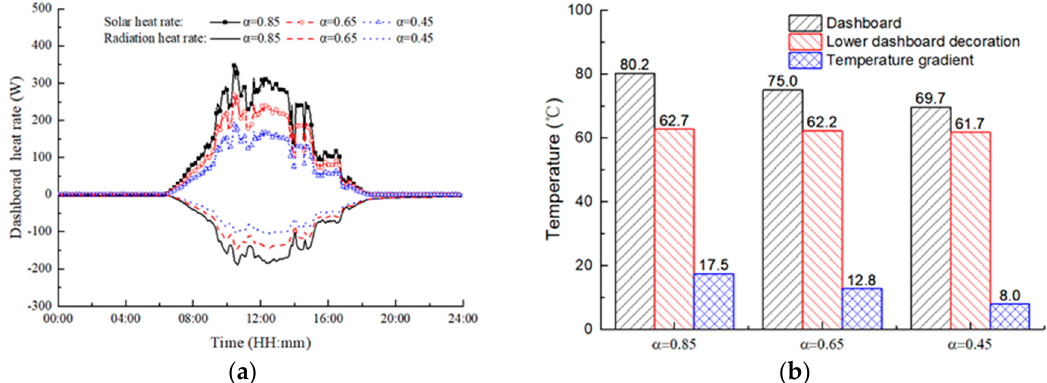
Figure 14. Influence of absorptivity on regulation of heat transfer and temperature gradient: ( a ) solar radiation and radiant heat dissipation; and ( b ) maximum temperature and temperature gradient.